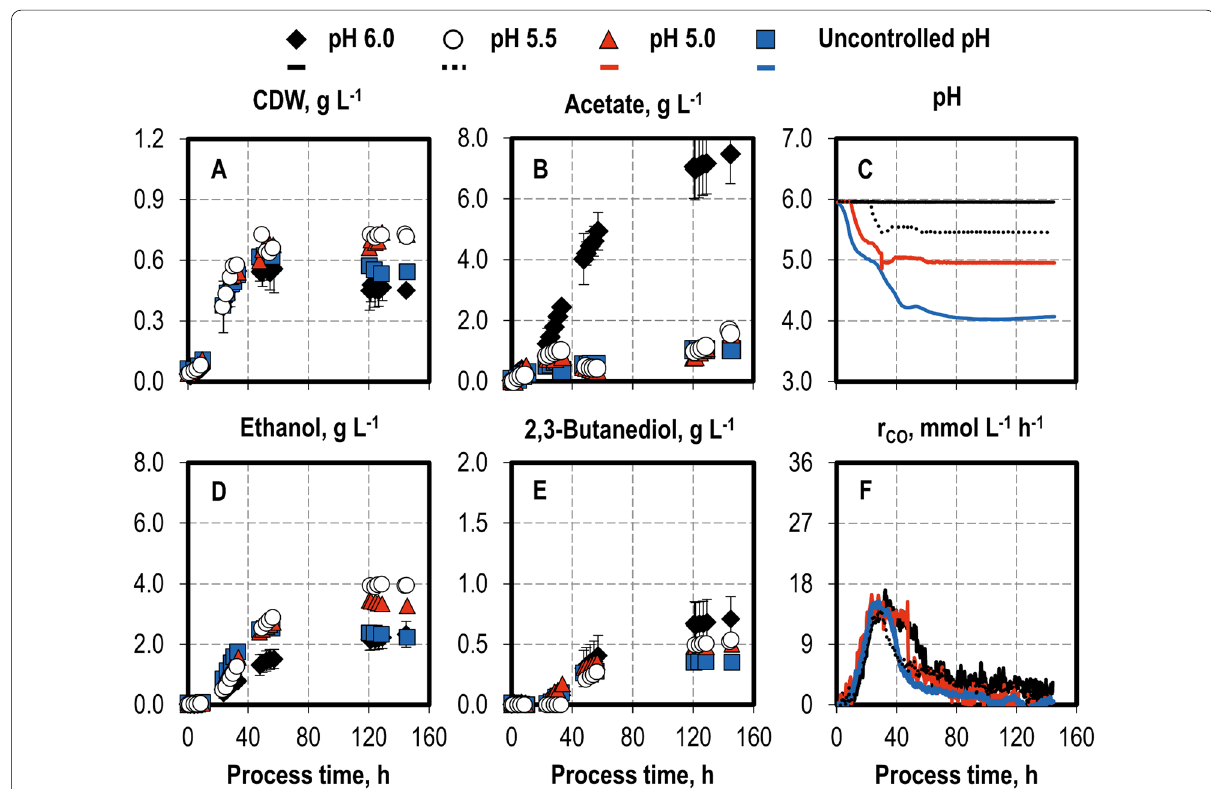
Fig. 1 Variation of pH profiles in autotrophic batch processes with C. ragsdalei in a continuously gassed STR. Cell dry weight ( A CDW) and product concentrations ( B acetate; D ethanol; E 2,3‑butanediol), pH ( C ) and CO uptake rates ( F r CO ): final pH 6 (black diamonds, black lines), pH 5.5 (white circles, dashed lines), pH 5.0 (red triangles, red lines), and uncontrolled pH (blue squares, blue lines). The batch processes were operated at a temperature of 37 °C, working volume of 1 L, volumetric power input of 3.5 W L − 1 , initial pH of pH 6.0, and a gas flow rate of 5 NL h − 1 with inlet partial pressure of 0.2 bar H 2 , 0.2 bar CO 2 , and 0.6 bar CO. Standard deviations are shown for the processes at pH 6.0, which were conducted in triplicate; CO uptake rates are shown without standard